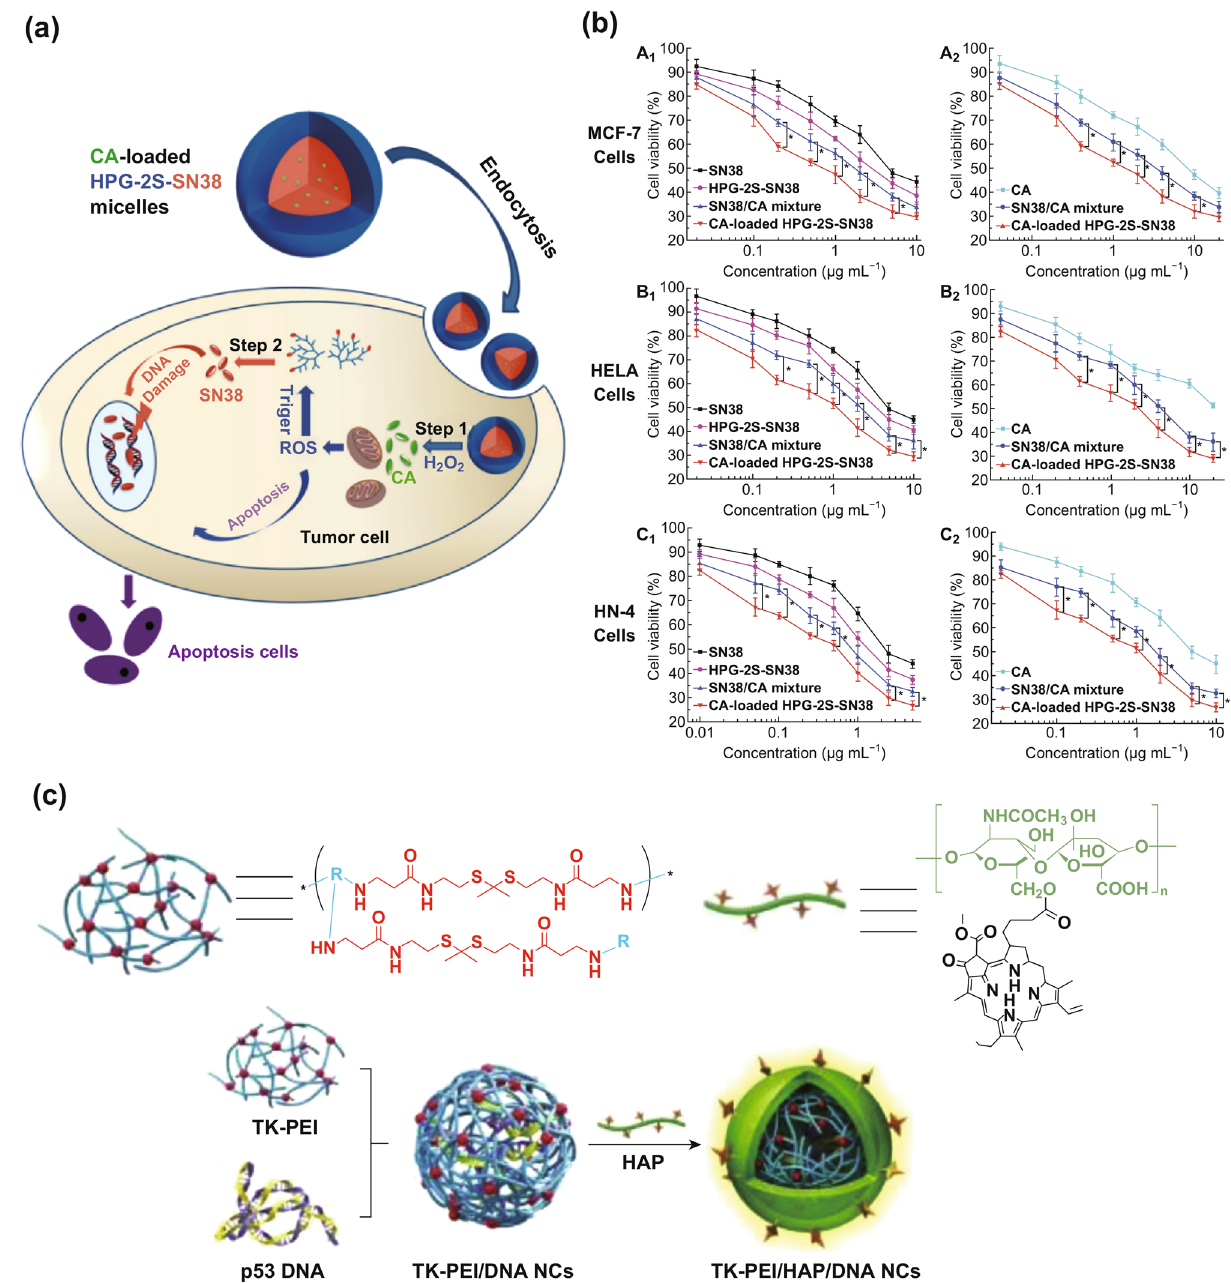
Fig. 11 a Schematic diagram of the mechanism of apoptosis induced by CA-loaded HPG-2S-SN38 nanomicelles. b Cell viability was (A1, A2) MCF-7 cells, (B1, B2) HeLa cells and (C1, C2) HN-4 cells were treated with CA, SN38, HPG-2S-SN38 micelles after 48 h, physical mixture of SN38 CA and CA-loaded HPG-2S-SN38 micelles were at various SN38 (A1, B1, C1) and CA (A2, B2, C2) concentrations. Adapted with per- mission from Ref. [64]. Copyright 2015 The Royal Society of Chemistry. c Schematic illustration of light-assisted p53 gene delivery and PDT for cooperative anticancer therapy. Adapted with permission from Ref. [65]. Copyright 2018 Elsevier Ltd